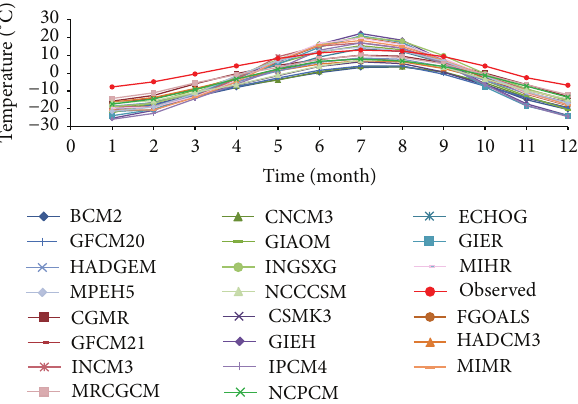
Figure 6: Comparison of precipitation on the Tibetan Plateau between simulation and observation in reference period (1961– 1990).